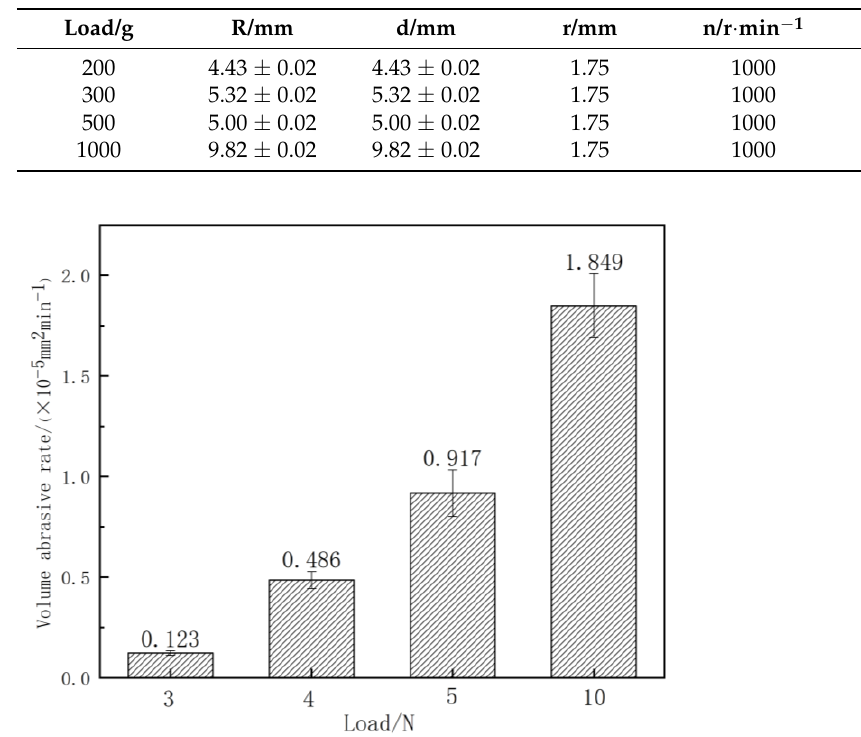
Figure 7. Friction coefficient of sample 4# with different load.